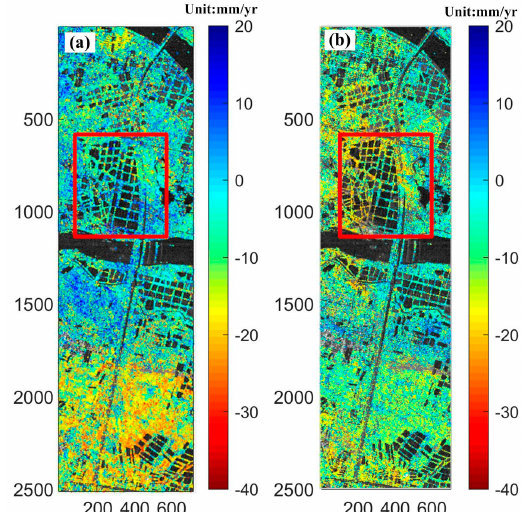
Figure 7. Deformation parameters of linear velocity models: ( a ) mean linear 𝑣 of MVM; ( b ) permanent 𝑣 of PVM